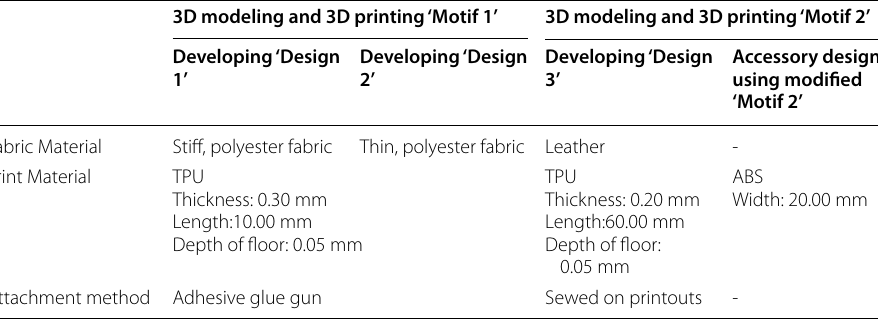
Table 10 Developing process of motifs and